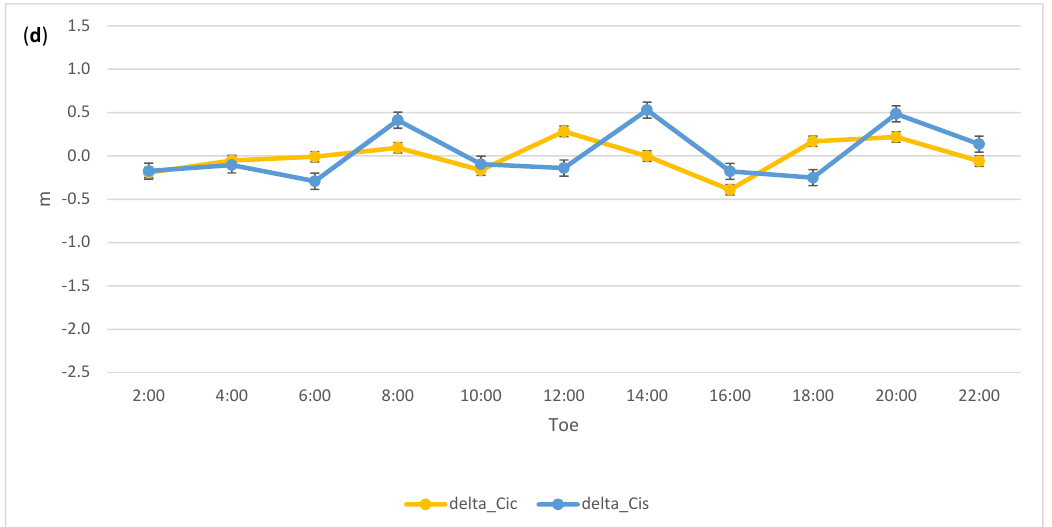
Figure 3. Best fitting corrections to ( a ) the clock polynomial parameters; ( b ) the Mean anomaly at Toe and amplitude of the cosine and sine perturbations along track (Cuc,Cus) due to the second zonal harmonic; the amplitude of the cosine and sine perturbations in the ( c ) radial (Crc, Crs) and ( d ) cross track (Cic, Cis) directions. To convert to radians the scale factor 26 × 10 6 m should be used. Error bars are 1 sigma formal uncertainties. Satellite G01 for day 2 January 2020.